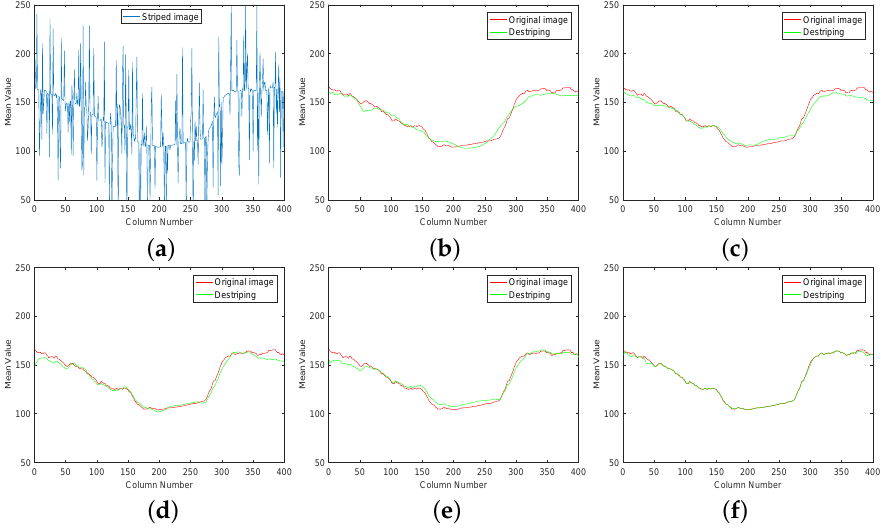
Figure 7. Column mean cross-track profiles of Figure 5. ( a ) Striped image; ( b ) WAFT; ( c ) SLD; ( d ) GSLV; ( e ) LRSID; ( f ) the proposed